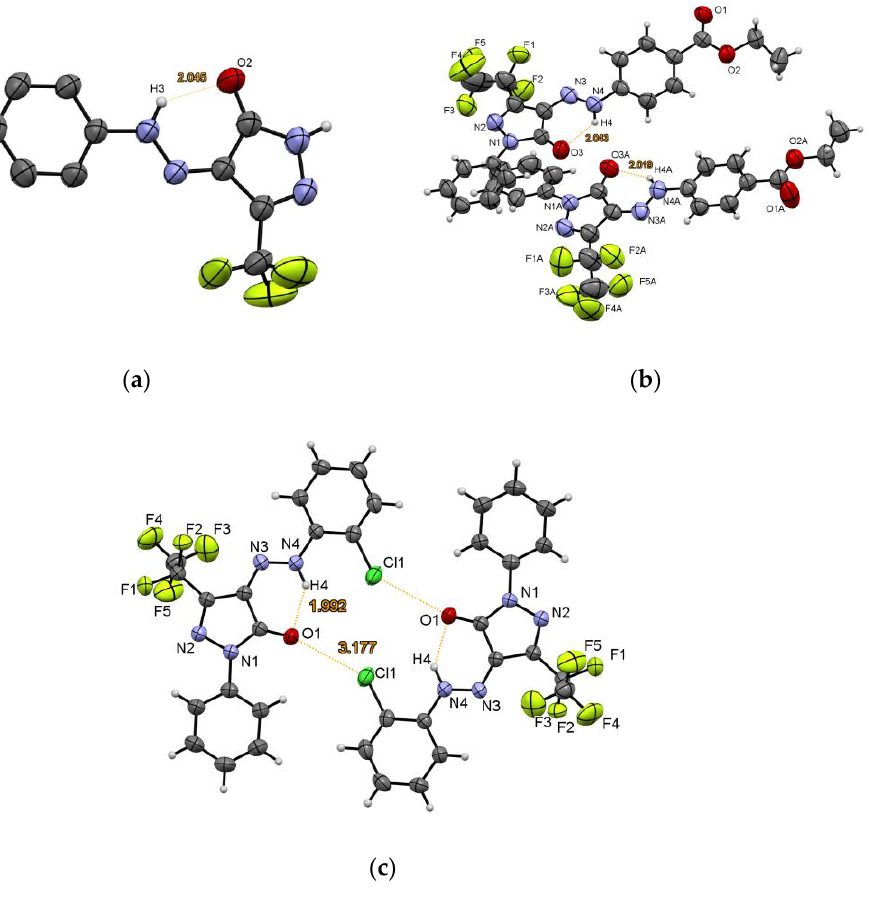
Figure 2. The ORTEP view of compounds 5b ( a ), 6c ( b ) and 6g ( c ) according to XRD data. The IR spectra of all compounds 5–9 recorded for the solid state had an absorption band of the carbonyl group at ν 1652–1667 cm –1 indicating their existence in Z - HA